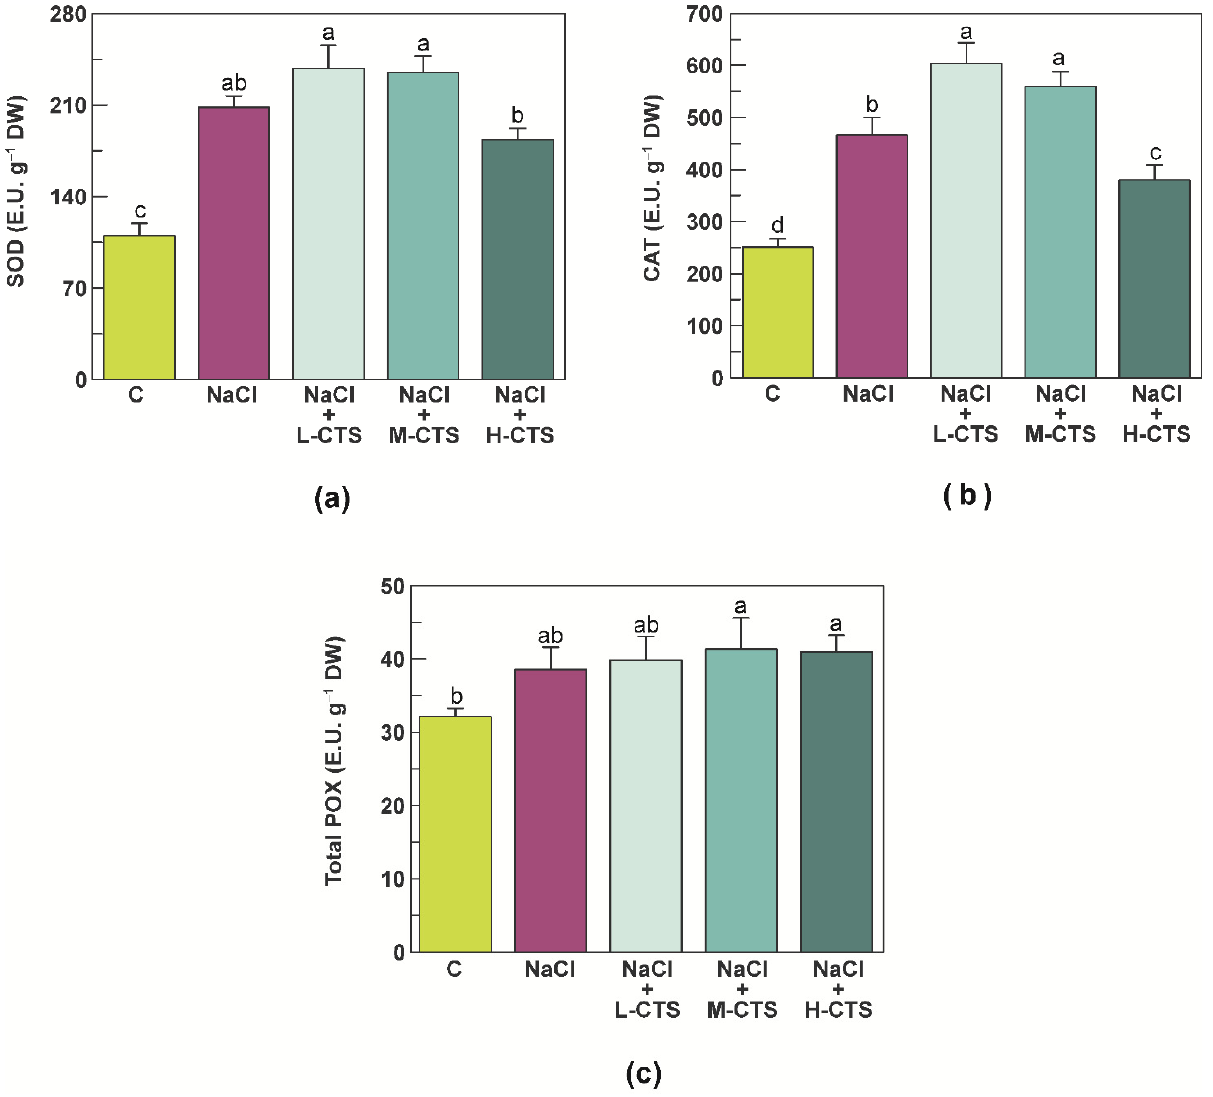
Figure 2. ( a ) Superoxide dismutase (SOD), ( b ) catalase (CAT) and ( c ) total peroxidase (POX) activities in the shoot of durum wheat seedlings grown under control, NaCl stress and NaCl stress + CTS treatment. Vertical bars represent S.D. ( n = 3). Different letters indicate significant differences according to the Tukey’s test ( p ≤ 0.05).